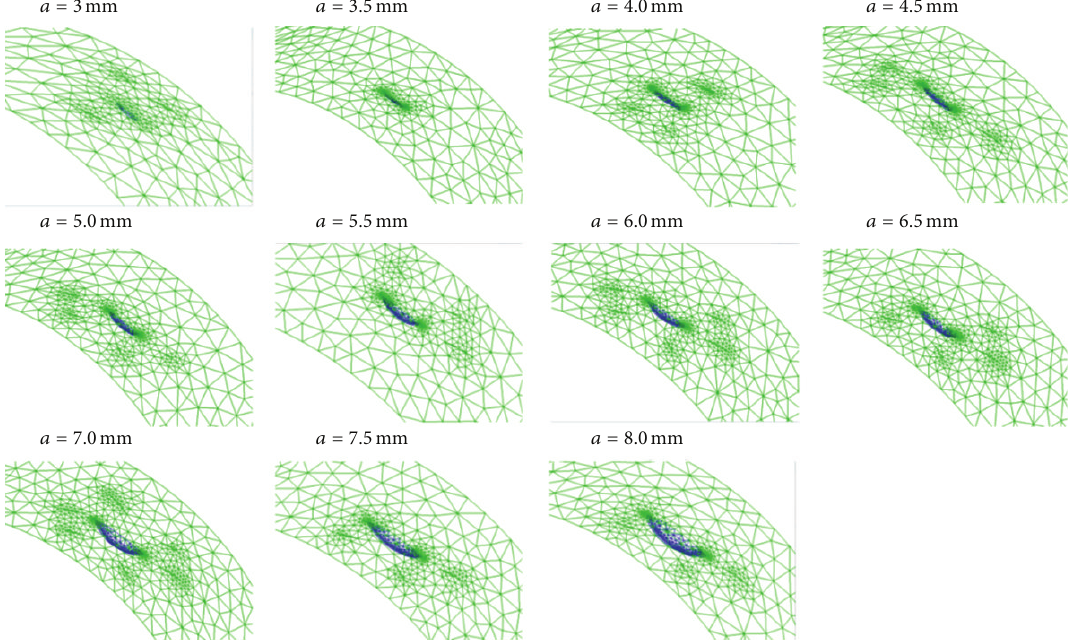
Figure 8: Growing shape and size of circumferential crack.